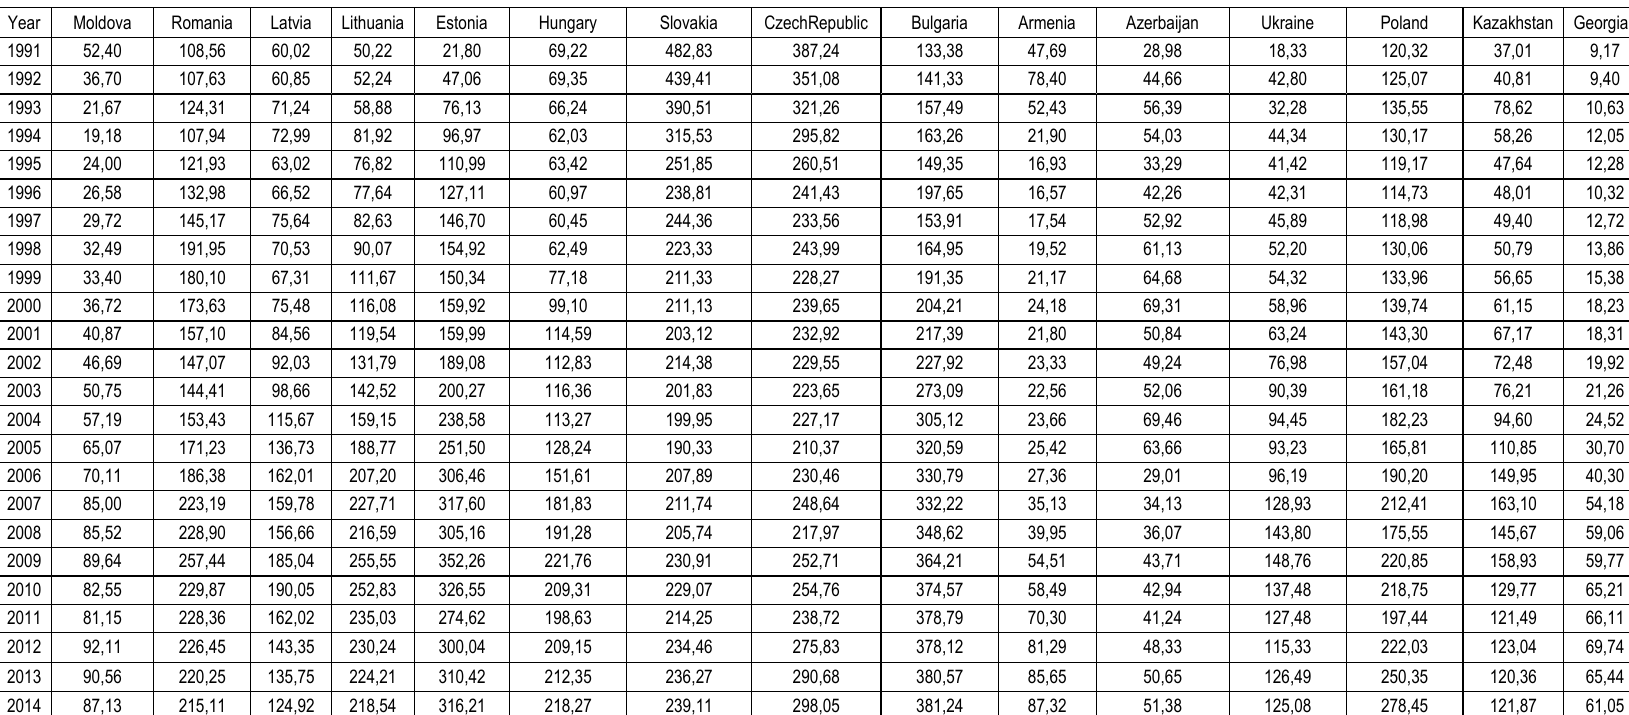
Table 4. The results of calculation of the index of financialization for the countries of Central and Eastern Europe in the period